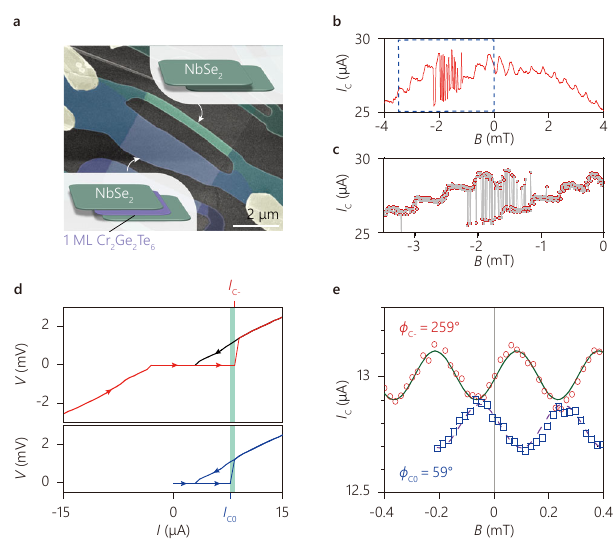
Fig. 3 Josephson phase measurement of the vdW SQUID devices with ultrathin magnetic insulator junction. a False-color SEM image of the NbSe 2 SQUID device with and without a 1 ML Cr 2 Ge 2 Te 6 barrier (Cr 2 Ge 2 Te 6 -SQUID). The inset shows a schematic of cross-section of the junctions indicated by arrows. b The SQUID oscillates with telegram-like critical current between the fi elds of − 1.1 and − 2.2 mT, which implies the presence of two metastable state. The loop area ( ≈ 4.5 μ m 2 , including the area for screening ≈ 2 μ m 2 ) agrees with the area calculated from the oscillation period ~4 – 6 μ m 2 . c The detailed view of the switching region of bistable SQUID critical current oscillations marked by dashed box in ( b ). d The SQUID device is similar to the one shown in ( b ) but with a smaller critical current. The sweep-dependent critical currents for Cr 2 Ge 2 Te 6 - SQUID measured at T = 1.1 K. The red line in the top panel depicts the sweep from negative bias (current) to positive bias, with switching current I C − . The black line depicts the sweep from positive bias to zero bias. The blue line in the bottom panel depicts the sweep from positive bias to zero bias followed by a sweep from zero bias to positive bias, whose switching current I C0 is lower than I C − . The green area indicates the difference of the switching currents. e The Cr 2 Ge 2 Te 6 -SQUID oscillation. The loop area ( ≈ 7 μ m 2 , including the area for screening ≈ 4.5 μ m 2 ) agrees with the area calculated from the oscillation period ~7 μ m 2 . The fi eld is calibrated by three different sizes of aluminum SQUIDs located 0.1 mm away from the Cr 2 Ge 2 Te 6 -SQUID. This allows for precise calibration of zero fi eld and thus measurement of the phase of the SQUID oscillation. Red circles and blue rectangles represent I C − and I C0 measured at T = 0.9 K. Each branch has a different phase, indicated by a fi t to I C − and I C0 with the sine curves shown in green and